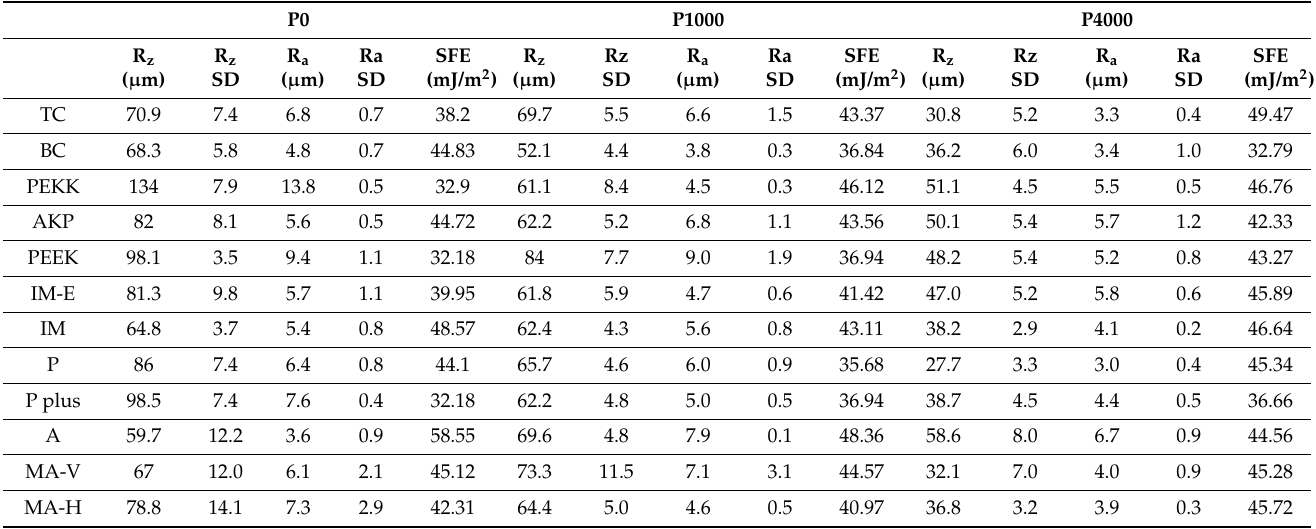
Table 3. Surface parameters (R z , R a , and SFE) for different polishing protocols (mean and standard deviation) on different materials with different polishing (P0, P1000, and